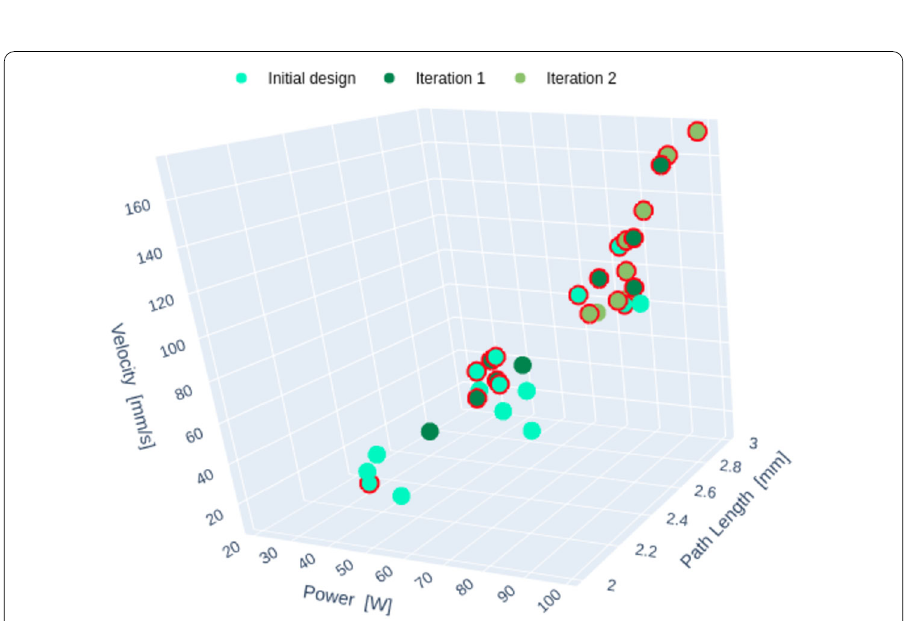
Figure 10 Case Study 1: Values of controllable process variables for the initial experimental design (cyan), iteration k = 1 (dark green) and iteration k = 2 (olive green). The red circle around the dots mark the runs belonging to the final Pareto set